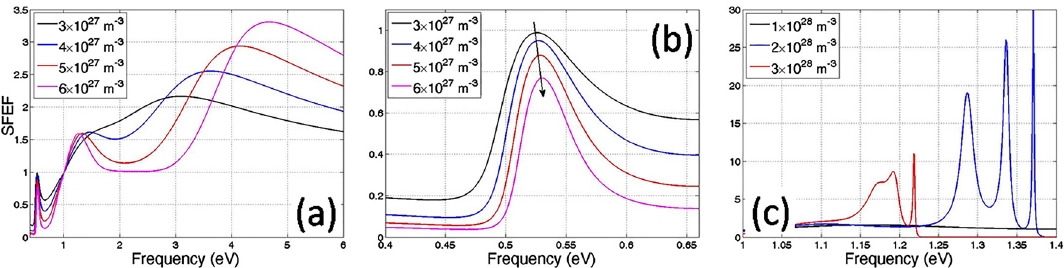
Figure 4: Spectra of the real and imaginary parts of the linear term (solid line) and full effective (brokenline) dielectric constantas defined by Eq. (12).